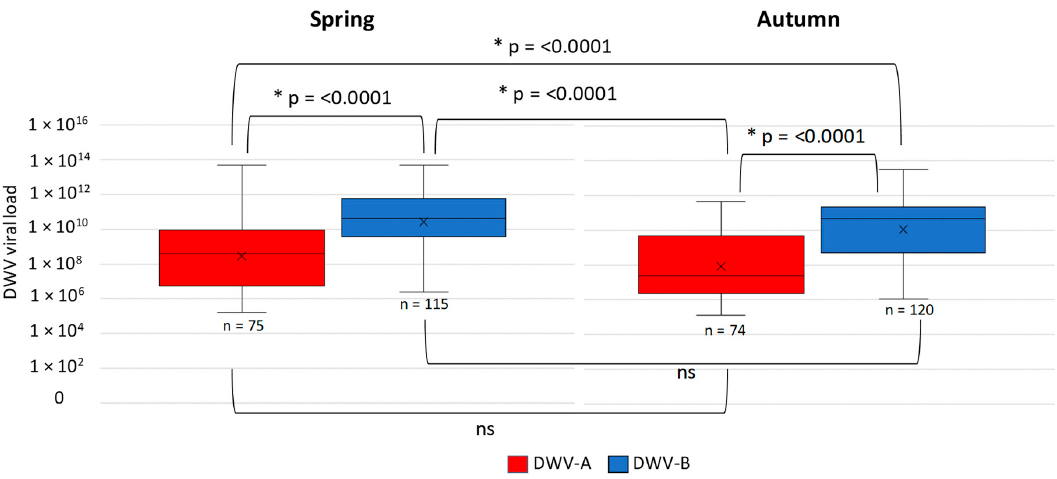
Figure 3. Colony level DWV-A (red) and -B (blue) viral load per season in RT-qPCR quantifiable colonies from England and Wales. Pairwise comparisons [46] are shown alongside non-significant (ns) and significant (*) results.